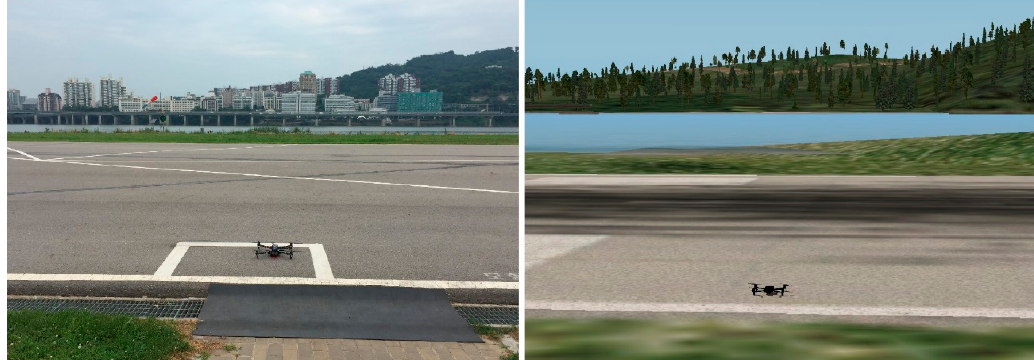
Figure 7. The real quadcopter in the real environment (Hangang Drone Park) ( left ) and the virtual quadcopter in the X ‐ Plane’s virtual environment (designed Hangang Drone Park) ( right ).